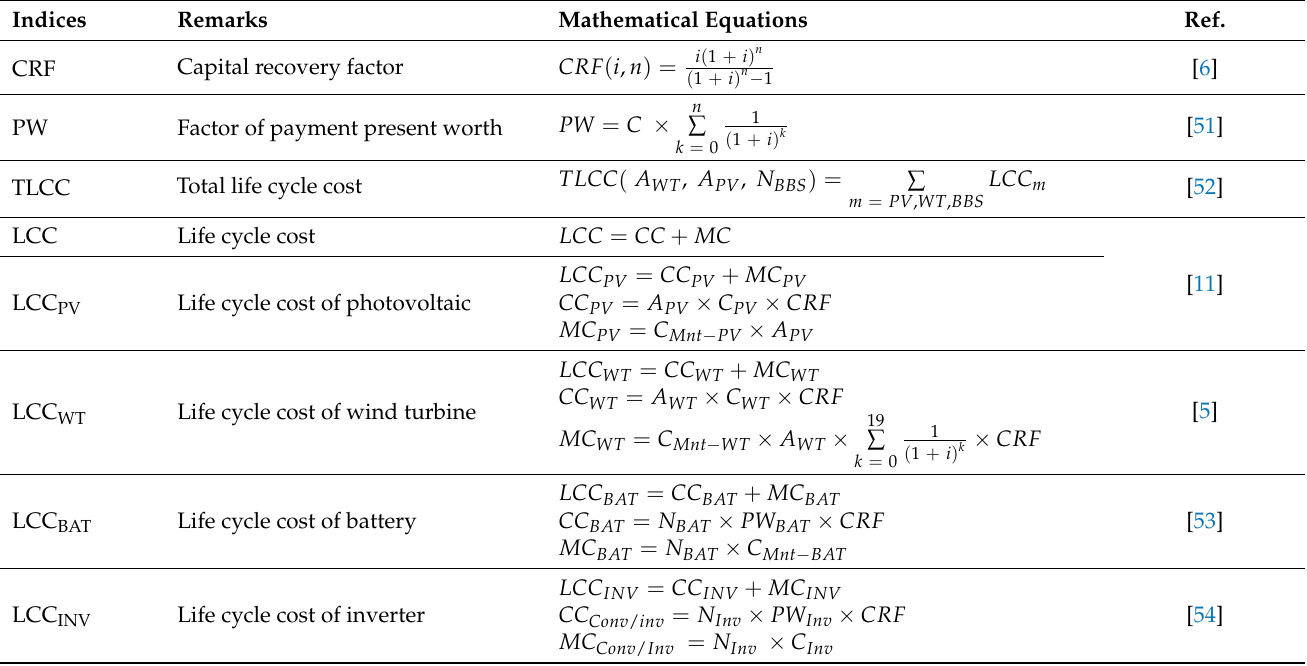
Table 3. A summary of some key HRES indicators based on mathematical